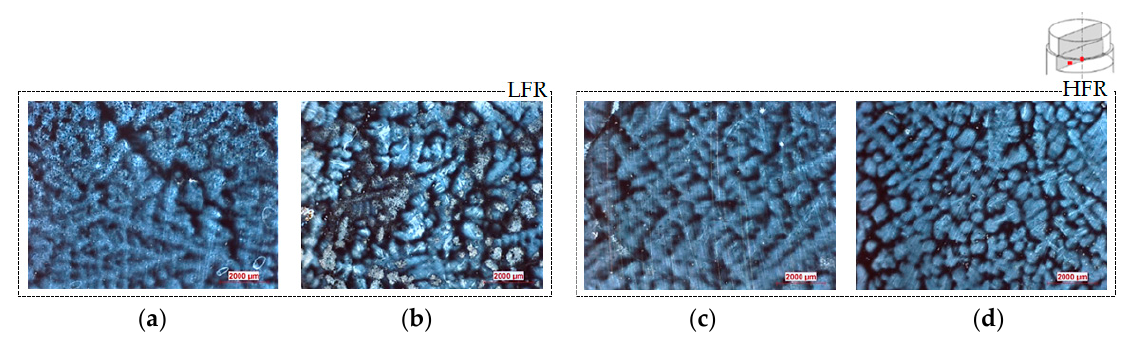
Figure 7. Micrographs along the bottom of the cutting section (30 cm below the hot-top/casting body separation position) of ingots LFR (left) and HFR (right): ( a , c ) In the 1/2 radius position from the center; ( b , d ) In the